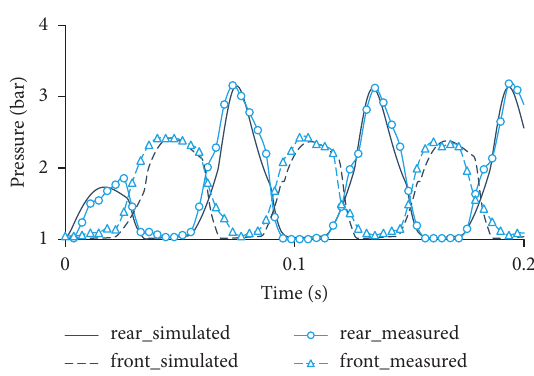
Figure 10: Pressure comparisons in the front and rear chambers at 4 bar.